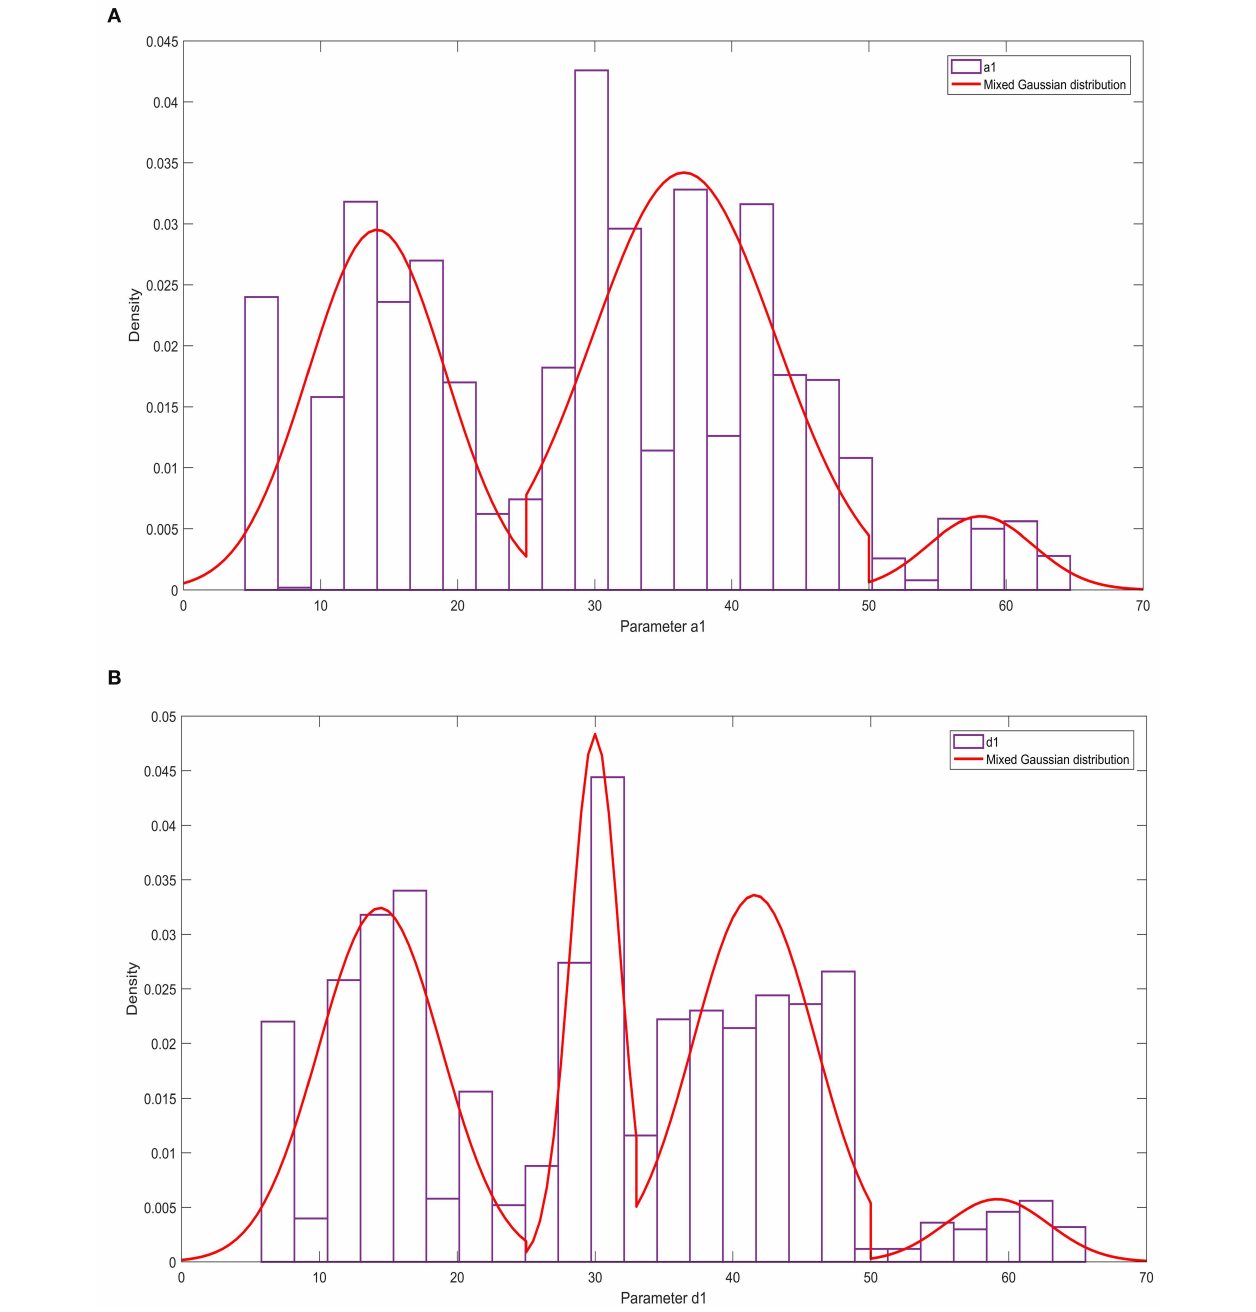
FIGURE 6 | The statistical law of parameters a1 and d1. (A) Histogram and probability density function of parameter a1; (B) Histogram and probability density function of parameter